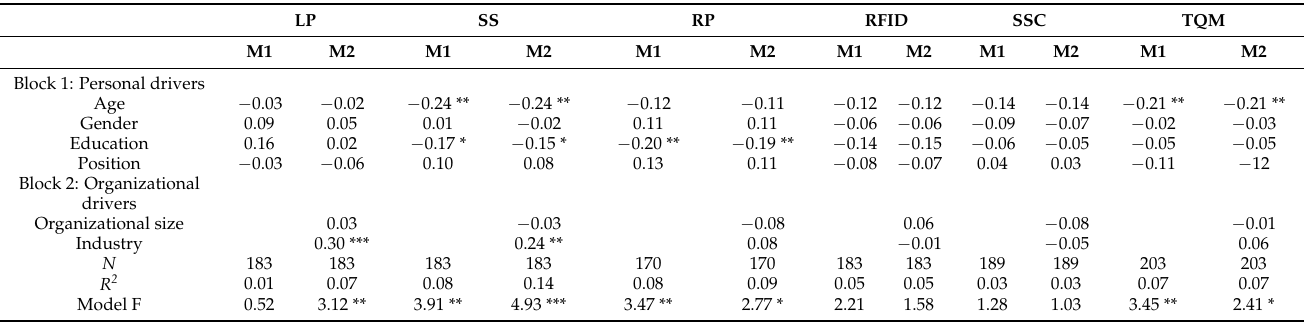
Table 3. Hierarchical regression results a .